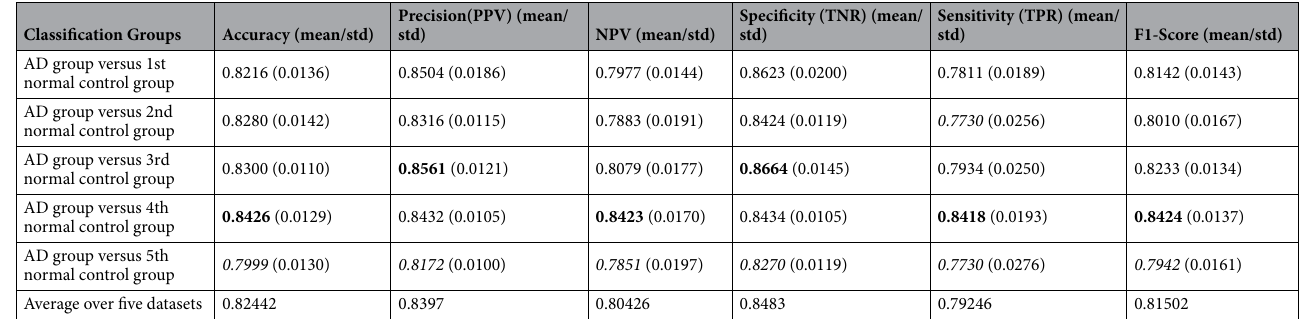
Table 3. Performance comparison of the overall classification for AD versus normal controls (NC)* with feature selection . *The mean and standard deviation values were extracted from five-fold cross validations. Bold font represents the most optimal performance for each measurement among five-fold cross validations. Italic font represents the least optimal performance. Abbreviation: AD = dementia caused by Alzheimer’s disease, NC = normal control, PPV = positive predictive value, NPV = negative predictive value, TNR = true negative rate, TPR = true positive